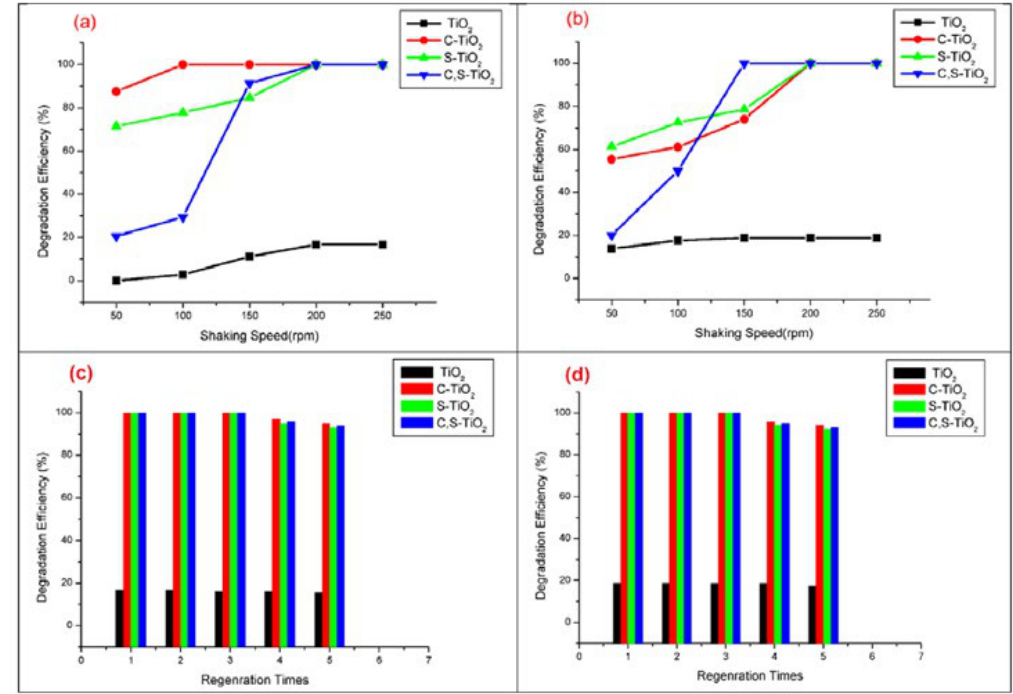
Fig. 8: Effect of shaking speed on the degradation efficiency RB-19 (a) and of RR-76 (b) and effect of regeneration times on the degradation efficiency RB-19 (c) and of RR-76 (d) present in industrial wastewater using TiO 2 , C-TiO 2 , S-TiO 2 and C,S-TiO 2 NPs as photocatalysts.